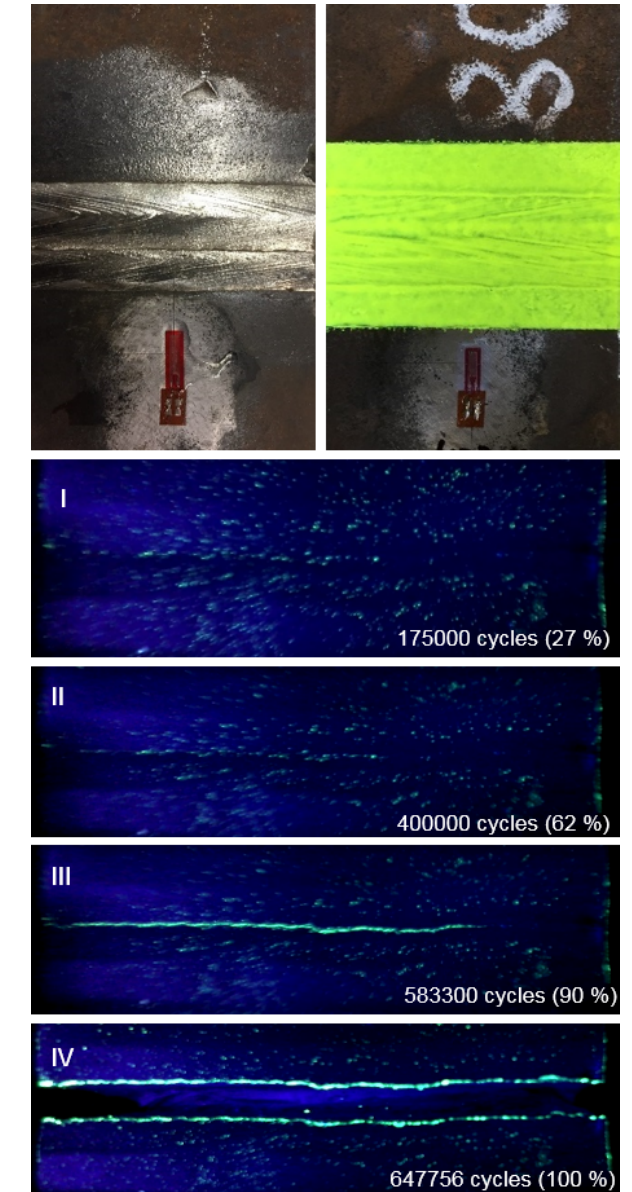
Figure 8. Butt weld without (top left) and with (top right) a fluo- rescence layer and stages I to IV of crack formation.